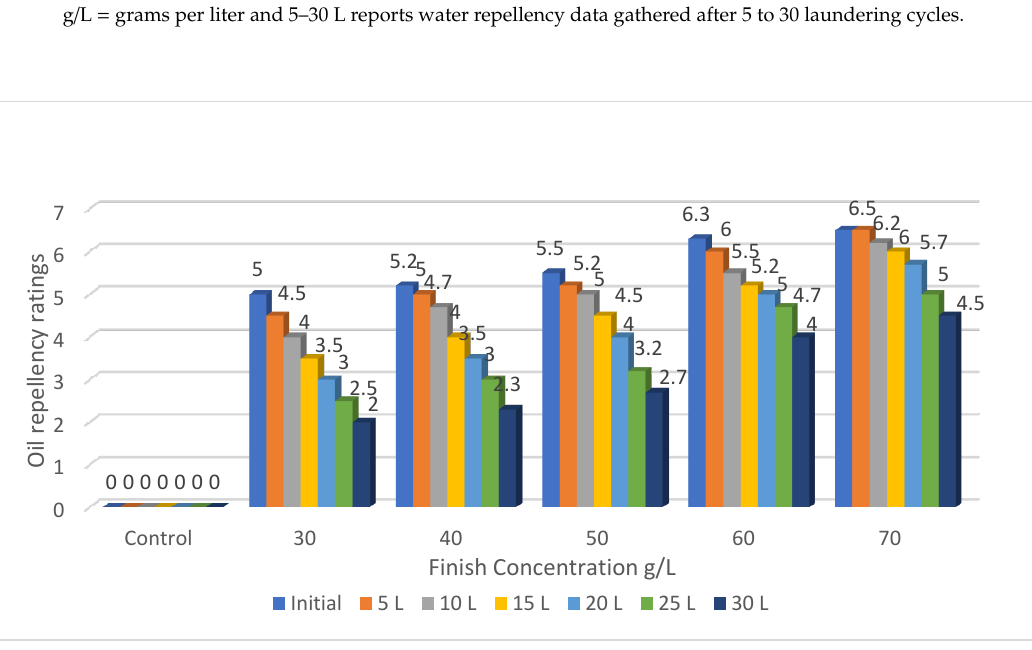
Table 4. Effect of different finish concentrations on the selected physical properties of polyester/cotton woven fabric. Finish Conc.